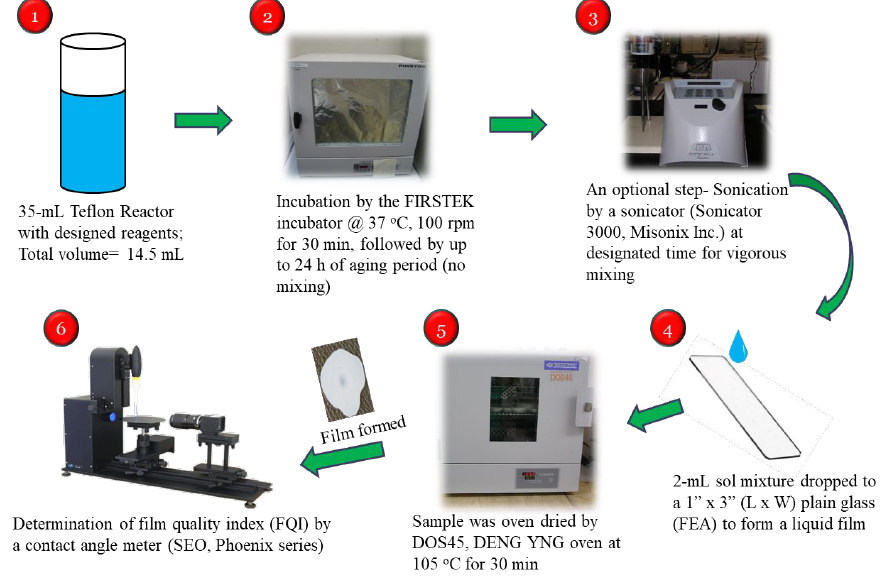
Figure 1. Sample handling and analyzing procedures used for preparing the sol-gel hydrophobic films.